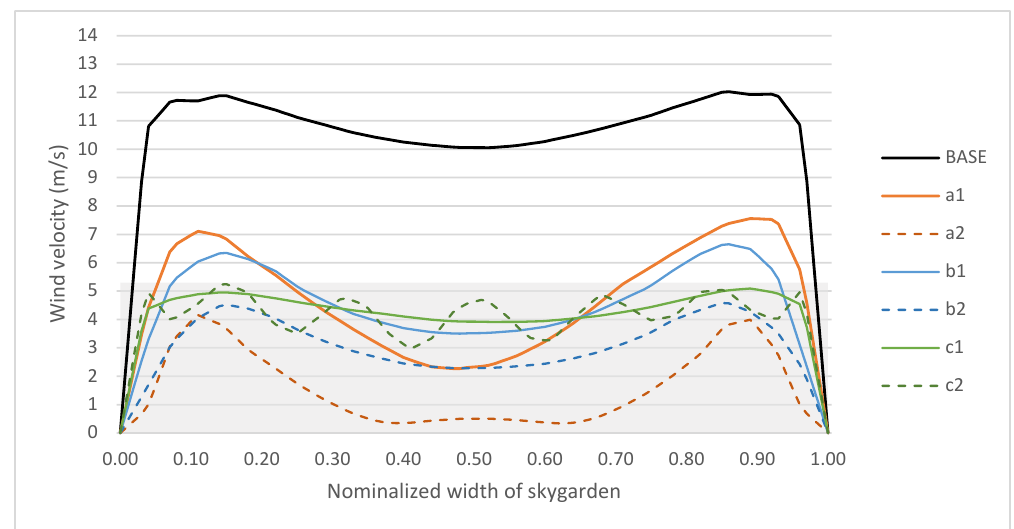
Figure 13. Velocity profile along the middle of the skygarden, the grey patch indicates wind speeds of quality class C and below; ( a1 ) railing 1.5 m, ( a2 ) railing 2 m, ( b1 ) hedge 1.5 m, ( b2 ) hedge 2 m, ( c1 ) tree 2.5 m, and ( c2 ) tree 5 m.